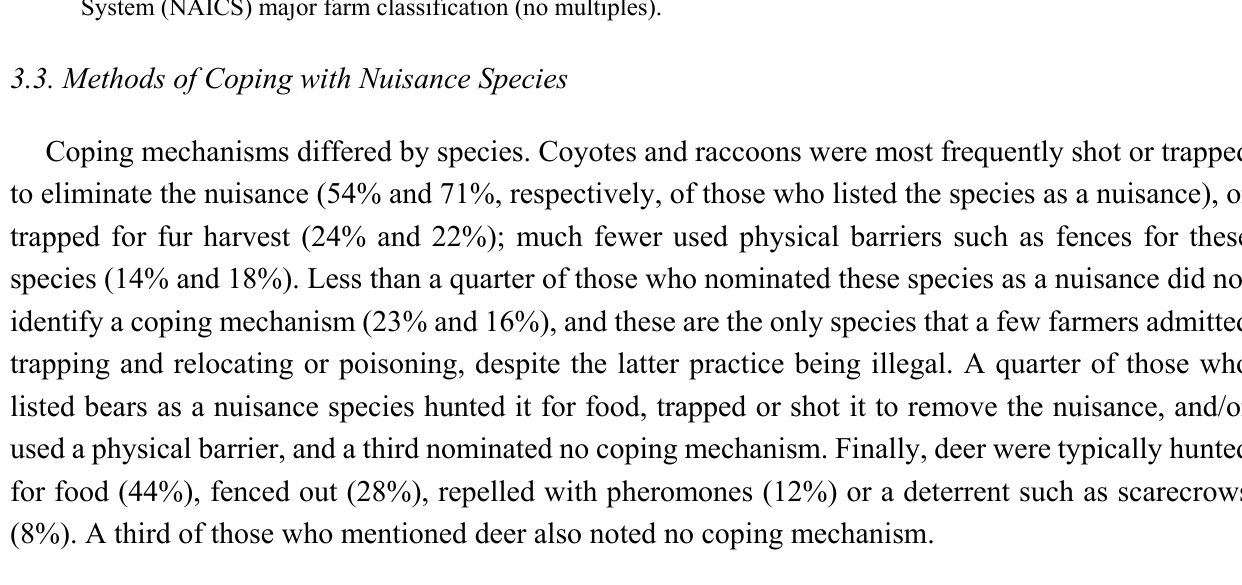
^ Based on Census of Agriculture Table 004-0203, as the proportion of all farms with Christmas trees, woodlands, or wetlands; rest in column from Table 004-0200 based on North American Industry Classification System (NAICS) major farm classification (no